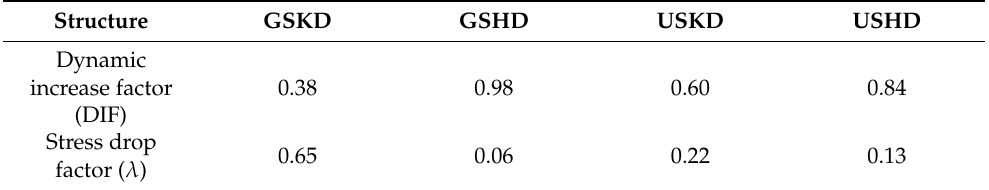
Figure 6. Stress–strain and energy absorption-strain curves under a strain rate of 2.22 × 10 − 3 /s. Wang [28] defined a dimensionless parameter-stress drop factor λ to quantify the degree of stress drop, i.e., λ = ∆ σ / σ d , where ∆ σ is the interpolation of the initial stress peak and valley and σ d is the initial stress peak. The corresponding stress drop factors of the dotted structure under different velocity loading can be obtained in Table 2, and it can be clearly seen that the GSHD structure had the smallest stress drop factor of 0.06 and the GSKD structure had the largest of 0.65. This was mainly due to the fact that the GSKD had the lowest relative density, where the deformation occurred first and was more difficult to contact with the adjacent parts’ site. Table 2. Stress drop factor and dynamic increase factor of the lattice structures.